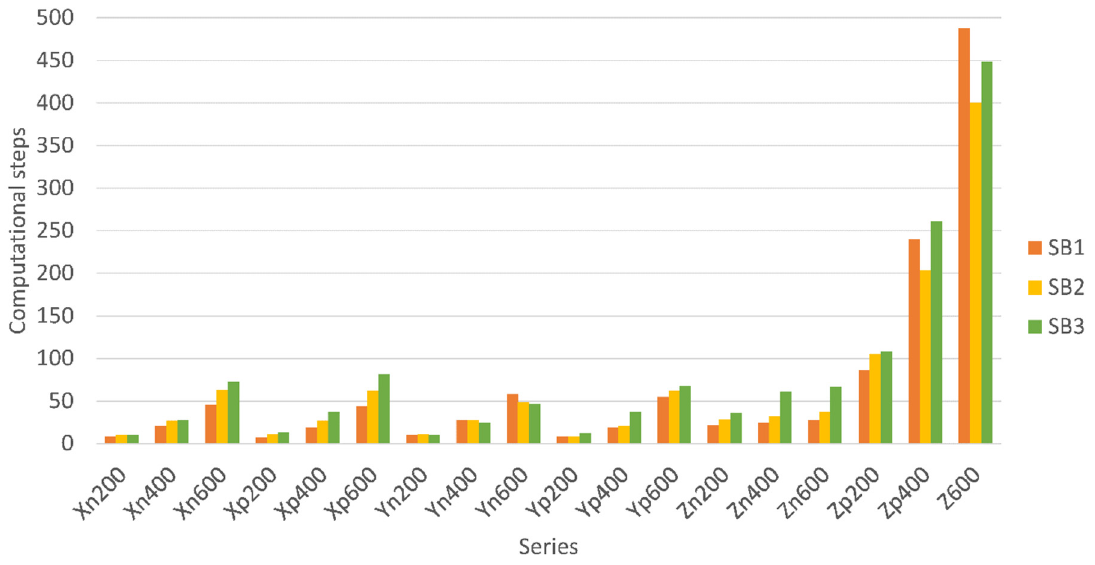
Figure 6. Computational steps in series dealing under the uni ‐ directional mode.